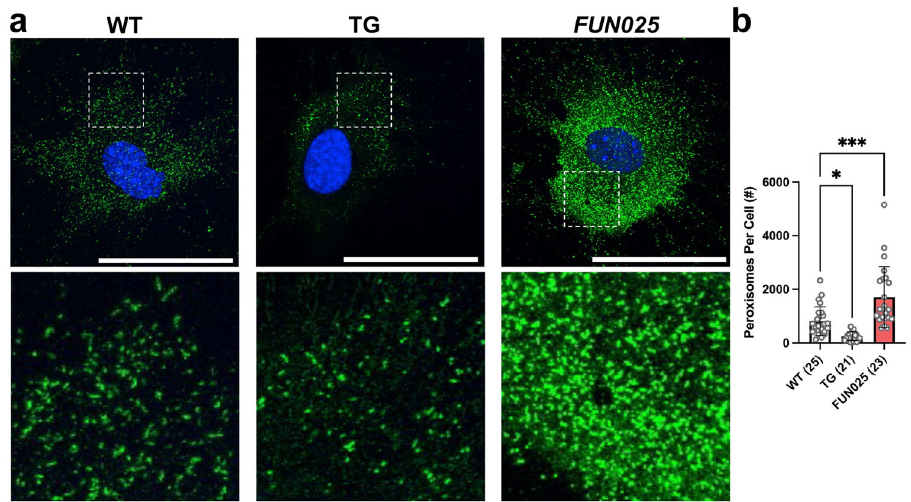
Fig. 5 TMEM135 regulates peroxisome proliferation in vitro. a Representative 60x immunohistochemical images of peroxisome biogenesis factor 14 (PEX14) labeled (green) and DAPI stained (blue) WT, Tmem135 TG (TG), and Tmem135 FUN025/FUN025 ( FUN025 ) fi broblasts. The white boxes in these images were expanded to show differences in the peroxisome number between these cells. Scale bar for images = 50 microns. b Quantitation of PEX14- positive peroxisomes from WT, Tmem135 TG, and Tmem135 FUN025/FUN025 livers using the Analyze Particles function in ImageJ. Asterisks (* and ***) indicates post hoc Tukey test for a P < 0.05 and P < 0.001 signi fi cance following a signi fi cant difference detected by one-way ANOVA. Number in parentheses represent the N of individual fi broblasts per genotype assessed in this experiment. Dots represent individual data points. Data are presented as mean ±